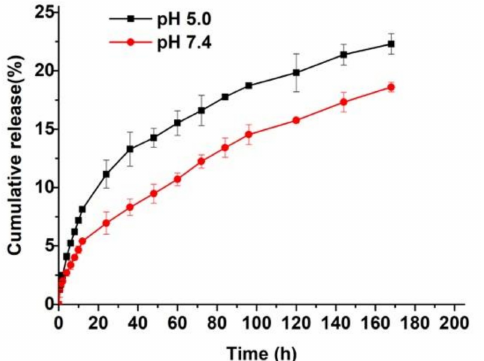
Figure 1. In vitro release profiles of DOX-NPs in PBS solution (pH 7.4) and acetate buffer saline (ABS) solution (pH 5.0),